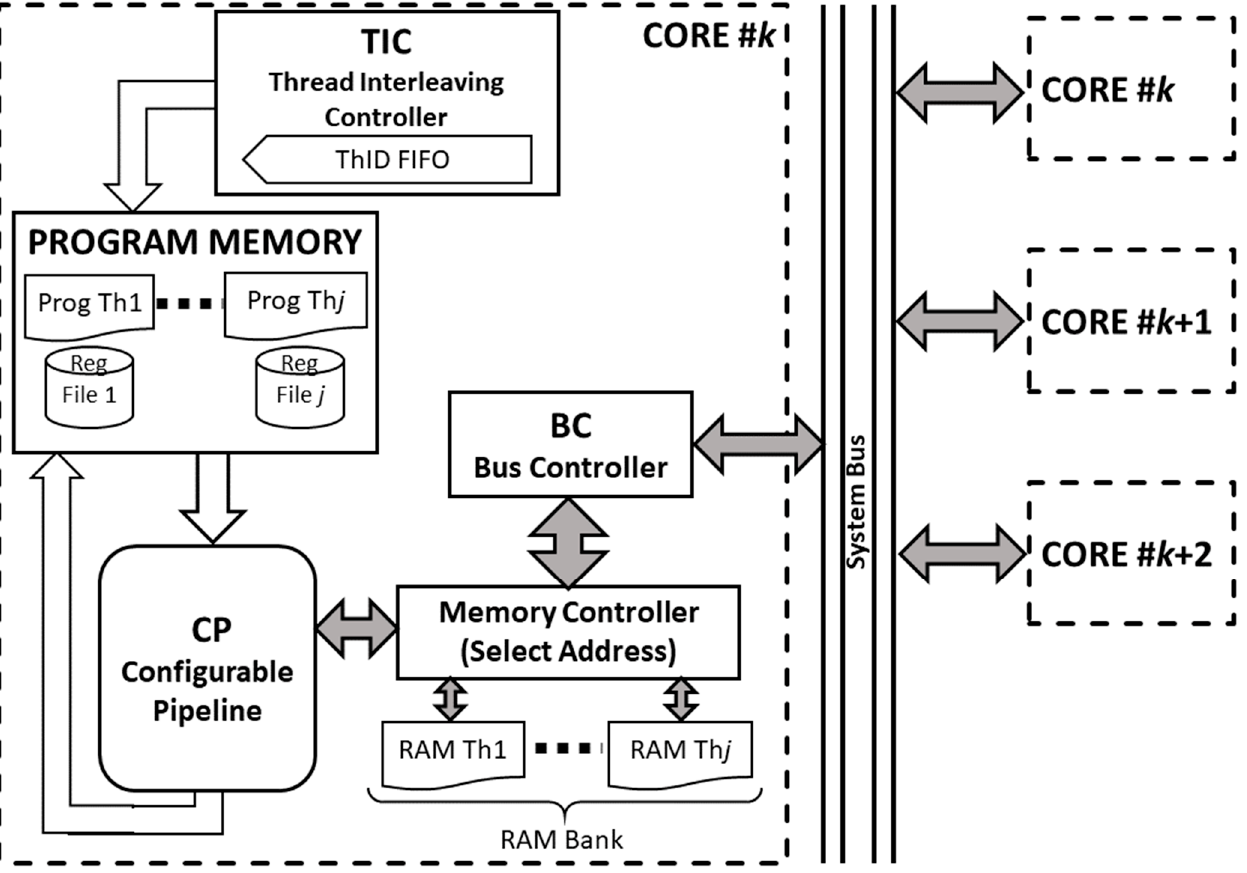
Figure 5. Architecture of a single core with pipeline processing and a thread-interleaving mecha- nism.